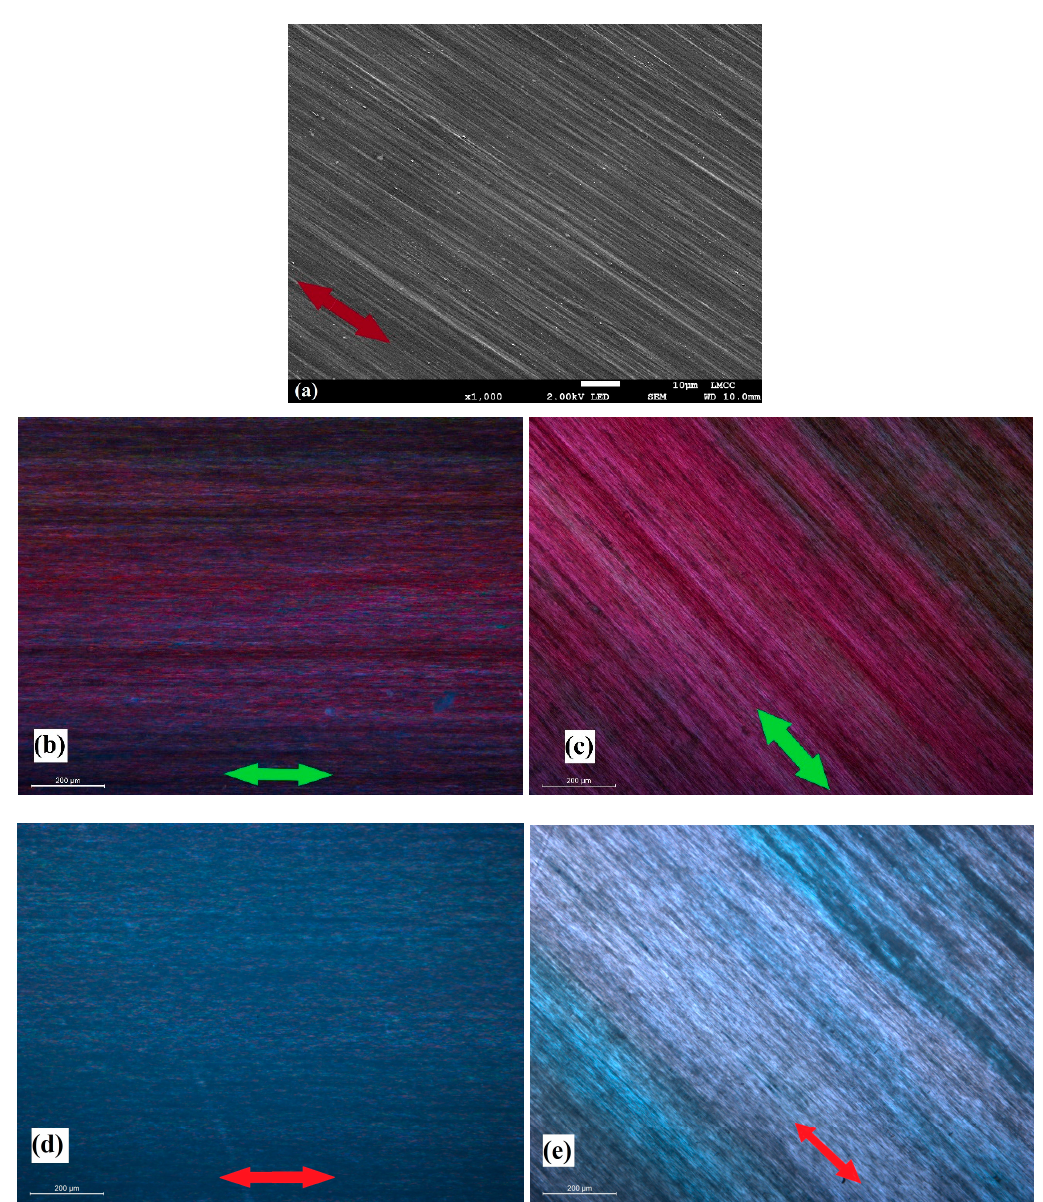
Figure 1. ( a ) SEM micrograph at 1000 magnification and ( b – e ) polarized light optical micrographs at two different angles for the medium draw ratio sample (DR100) with ( b , c ) the nanocomposites and ( d , e ) the plain dis-UHMWPE samples. The arrows show the orientation direction. ( b , d ) The polarized light is diagonal (45 ◦ ) and ( c , e ) the polarized light is perpendicular (90 ◦ ) to orientation direction. These data are in agreement with the VIS transmission spectra of the DR100 oriented nanocomposite in polarized light, shown in Figure 2. For 400 ≤ λ ≤ 700 nm, the nanocomposite exhibited an absorption spectrum that is strongly dependent on wavelength, the angle between the polarization direction of the incident light, and the drawing direction of the sample. Despite a limited transmittance, probably due to its thickness (~50 µ m) and its elevated draw ratio, which is likely to cause micro-voids, the sample showed a neat dichroic behavior. When the vibrating plane of polarized light was parallel to the ◦ drawing direction ( θ = 0 ), the absorption maximum was observed at 580 nm. However, in the case θ = 90 ◦ , i.e., when the vibrating plane of polarized light was perpendicular to the drawing direction, light was absorbed at lower wavelengths, with an absorption maximum of 398 nm. An isosbestic point was observed in the absorption spectra at a wavelength of 425